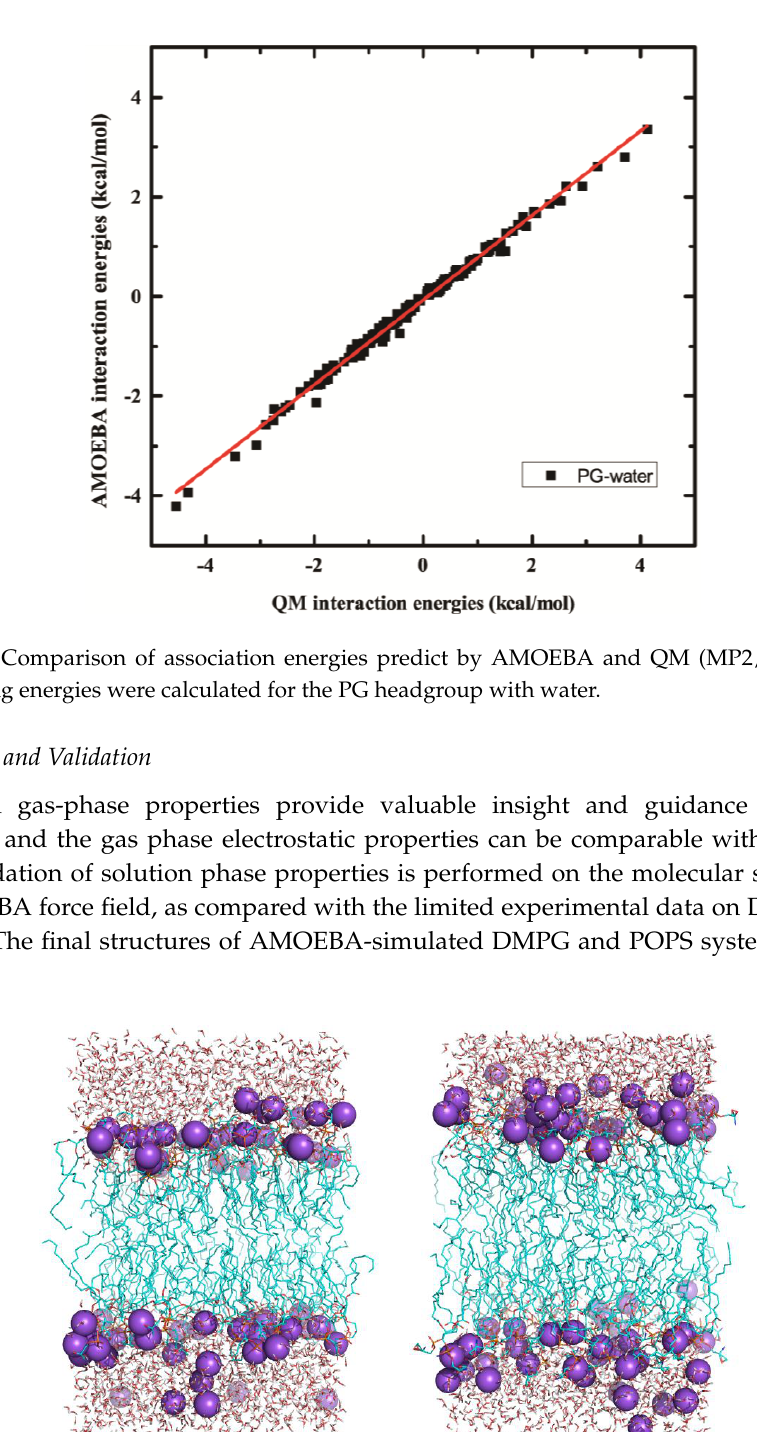
Figure 5. The structures of the DMPG ( a ); POPS ( b ) under tensionless situation after the production run.